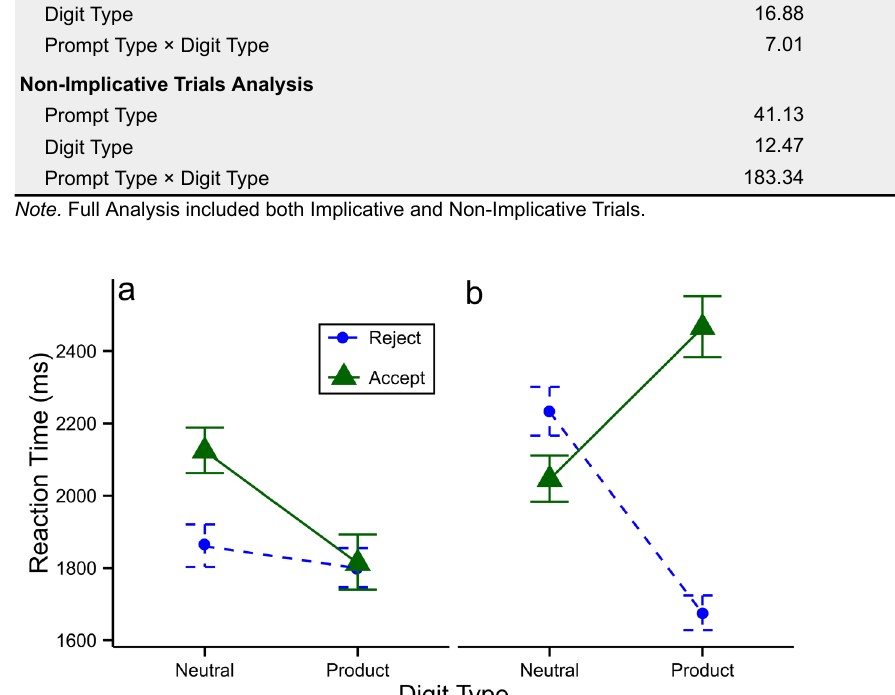
with participants being faster to accept correct prompts on Neutral vs. Product trials, Δ M = 1766 ms, t (47) = 5.204, Holm-adjusted p < .001, d = .751, and faster to reject incorrect prompts on Product vs. Neutral trials, Δ M = 1412 ms, t (47) = 9.266, Holm-adjusted p < .001, d =